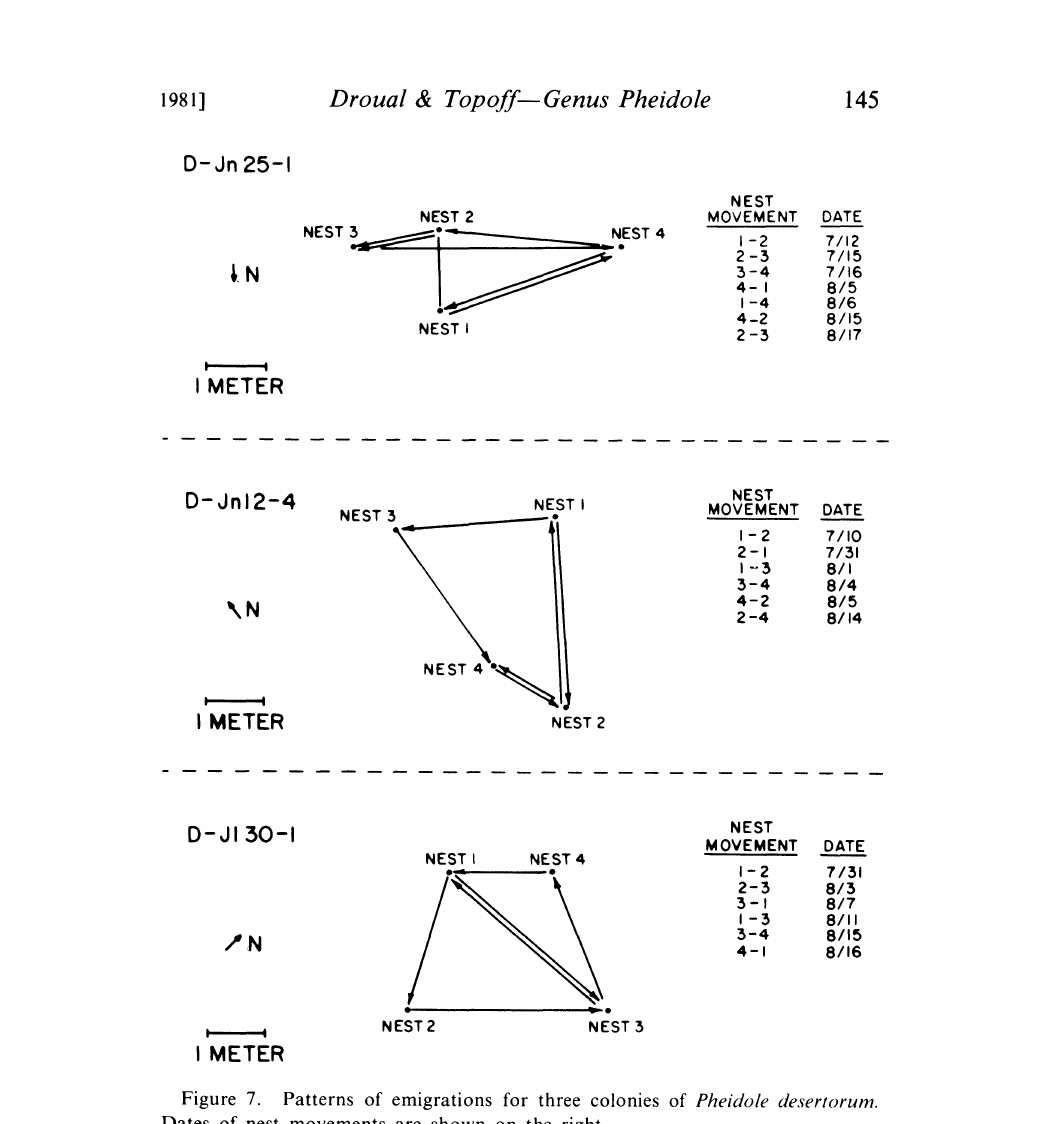
Figure 7. Patterns of emigrations for three colonies of Pheidole desertorum. Dates of nest movements are shown on the